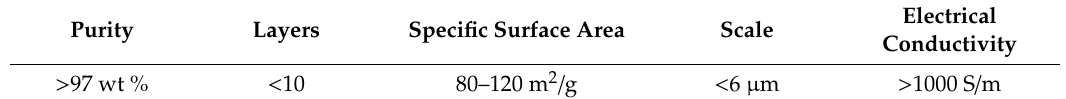
Table 1. Physical properties of graphene.